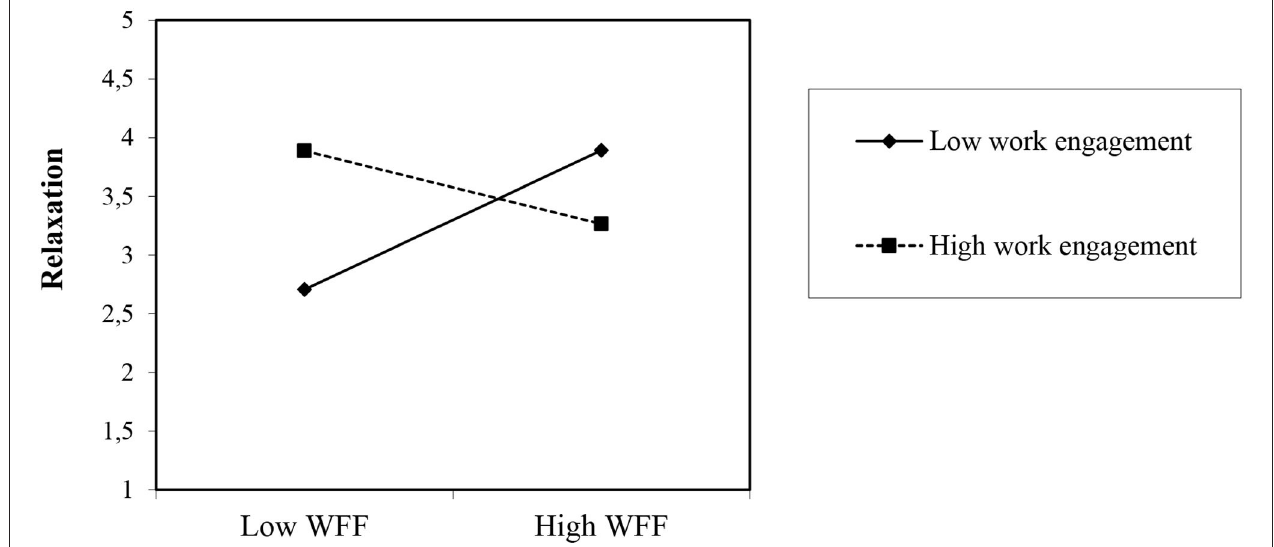
FIGURE 3 | Interaction effects of daily work engagement and day-level of WFF in predicting relaxation at night. WFF, Work-Family Facilitation.